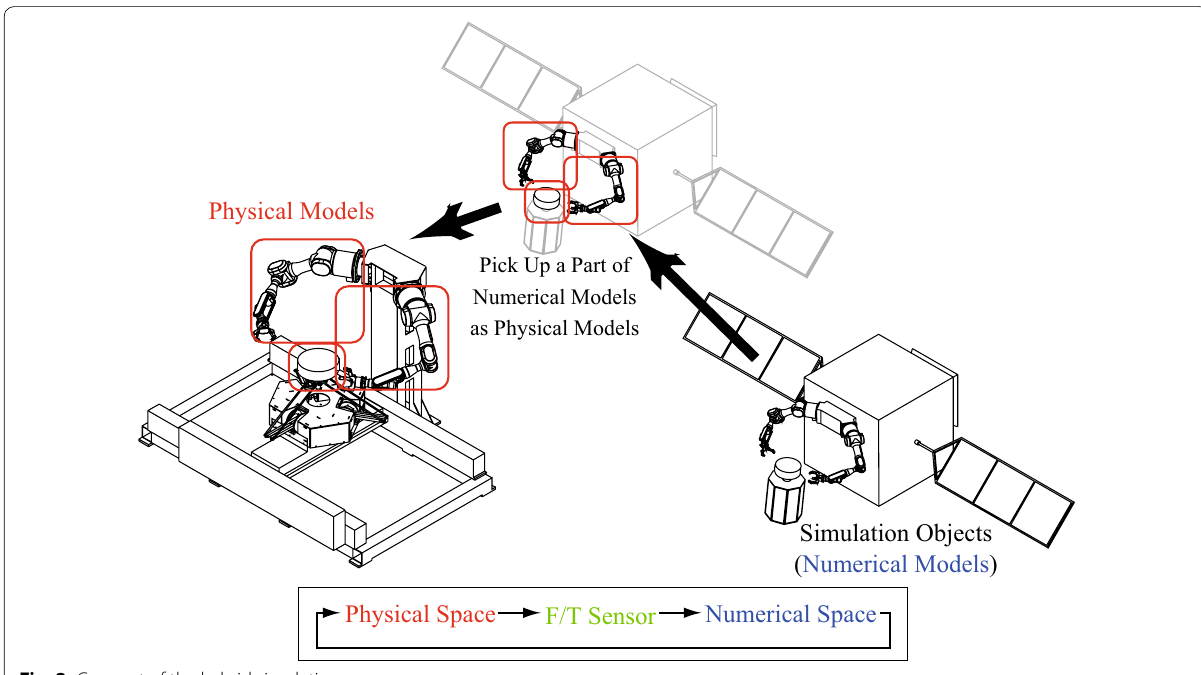
Fig. 2 Concept of the hybrid simulation